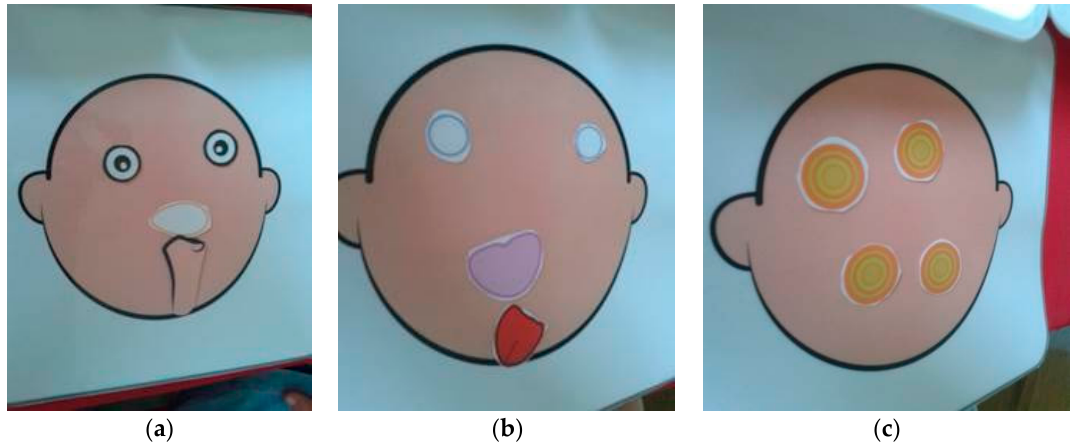
Figure 4. Children’ different strategies to complete the face. ( a ) Almost canonical ; ( b ) Not canonical ; ( c ) Still a